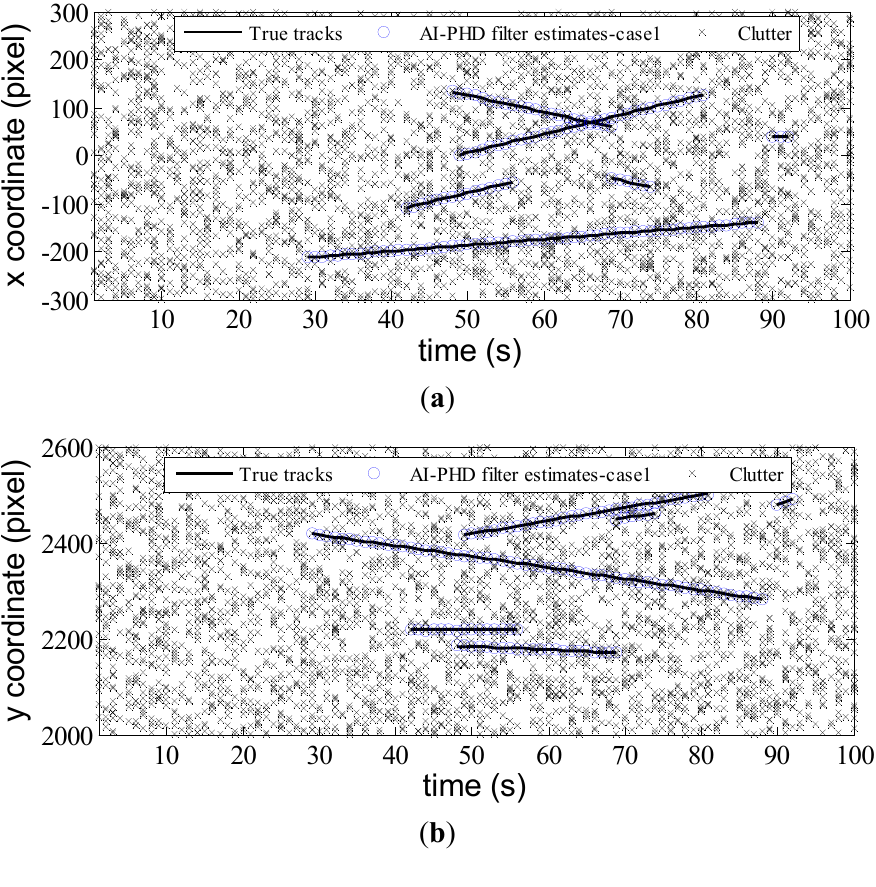
Figure 3. Filter estimates with unknown